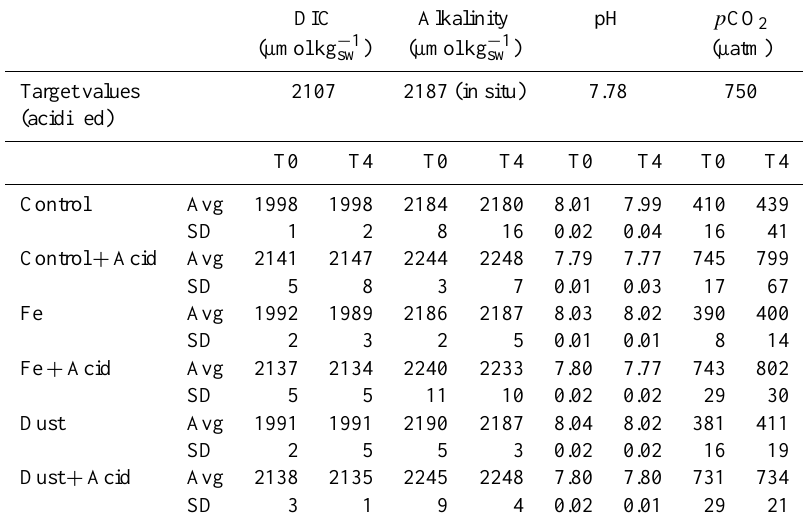
Table 2. Values of DIC, alkalinity, pH, and p CO 2 in each treatment at T0 and T4.